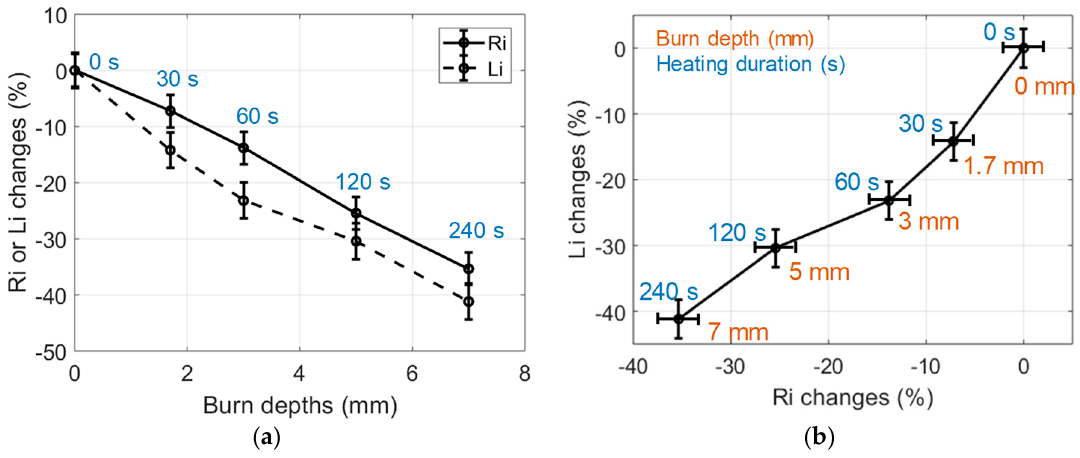
Figure 6 . ( a ) Changes of the dielectric properties of 150 °C IHP-samples expressed in % vs burn depths. Heating durations were 0, 30, 60, 120, 240 s; ( b ) Changes of the dielectric properties of 150 °C IHP-burned samples expressed in % in the ( R i , L i ) impedance plane (30 g samples).